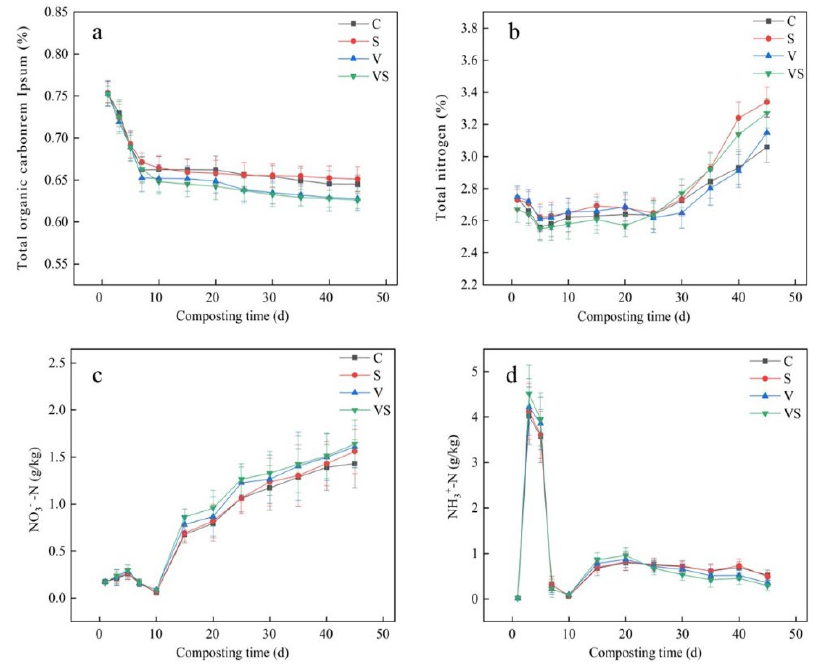
Figure 2. Changes in TC ( a ), TN ( b ), NO 3- -N ( c ), and NH 3+ -N ( d ) during composting of different experiment groups (control (C), ventilation (V), coral sand (S), ventilation and coral sand (VS)).